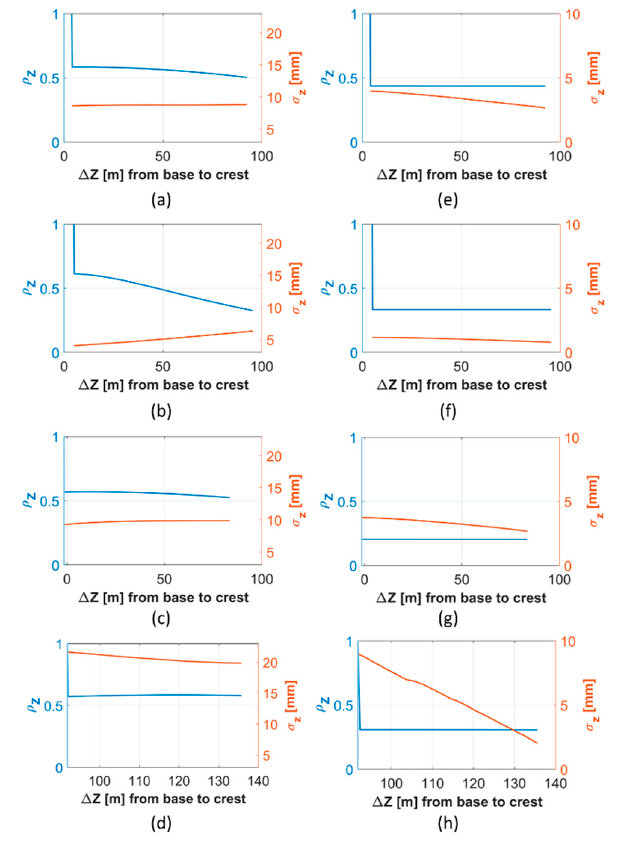
Figure 7. Left: spatial correlations, standard deviations (height)—complete synthetic VCM ( a ) S1, ( b ) S2, ( c ) S3, ( d ) S4; right: spatial correlations, standard deviations (height)—synthetic VCM with atmospheric elementary errors only ( e ) S1, ( f ) S2, ( g ) S3, ( h ) S4.